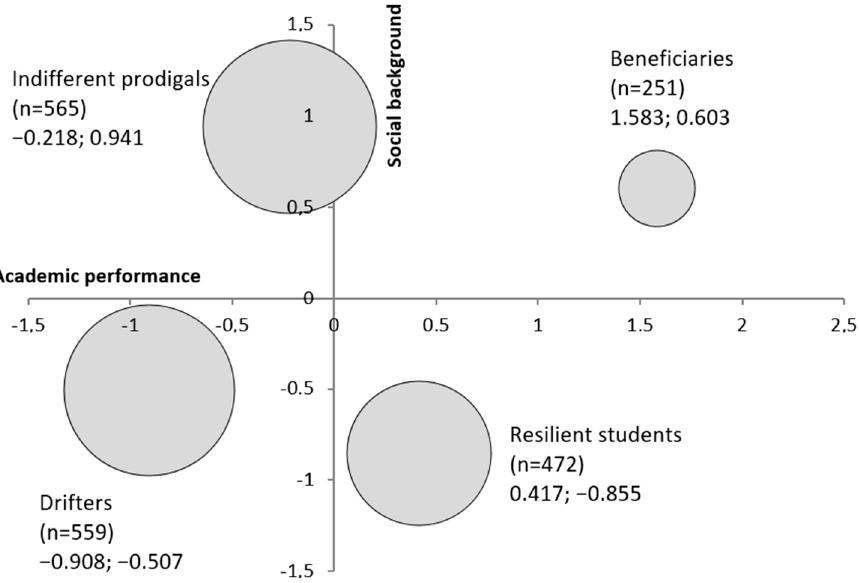
Figure 1. Clusters with respect to the social background index and the principal component of per- performance. 1 Source: Persist 2020 ( n = formance. 1 Source: Persist 2020 ( n = 2199).